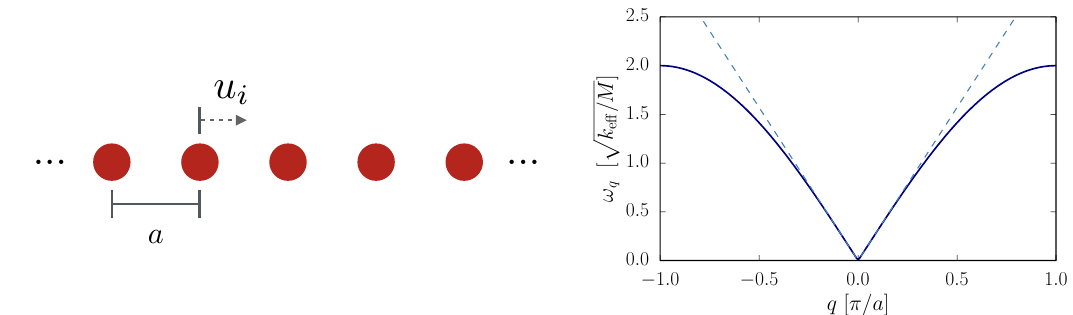
Figure 9: ( left ) A 1D lattice of atoms of mass M has a single longitudinal acoustic phonon branch. ( right ) The dispersion relation of the acoustic phonon is shown over the first Brillouin Zone; near q = 0, the phonon has a linear dispersion with slope given by the speed of